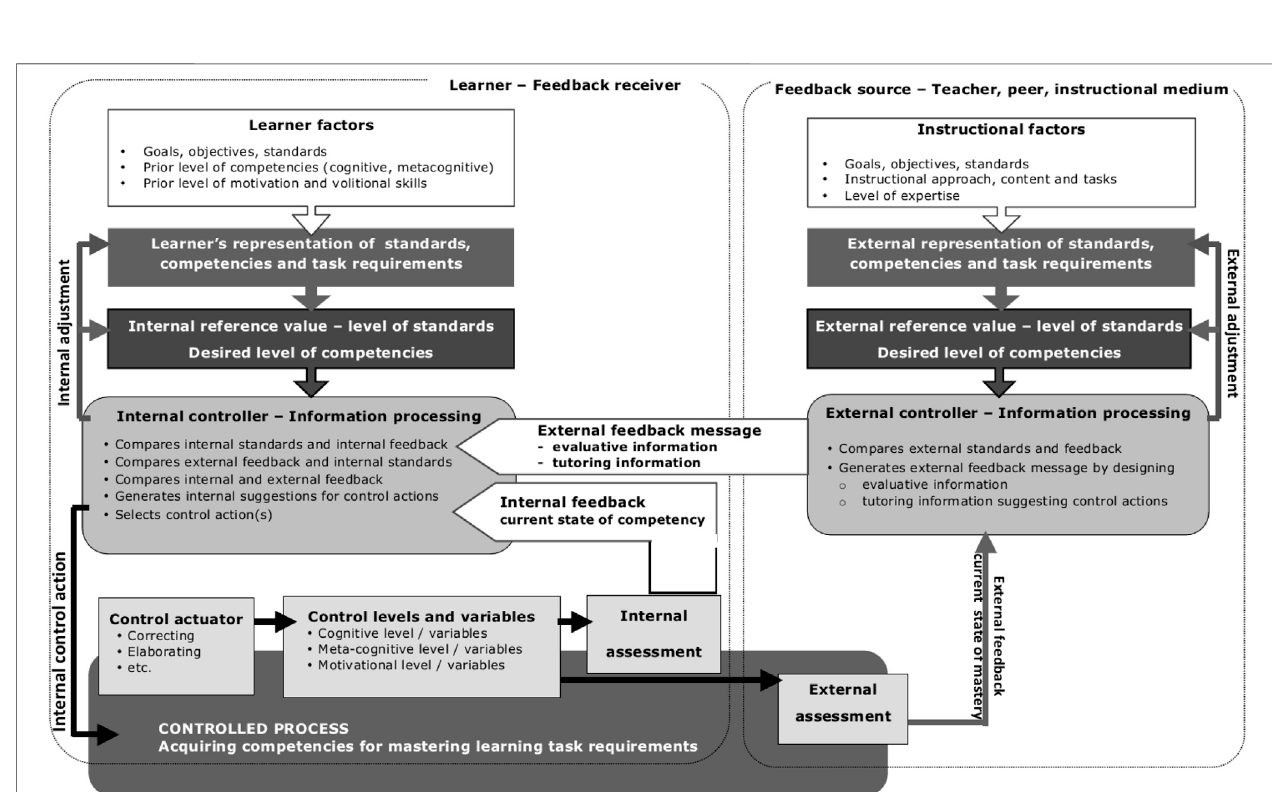
FIGURE 10 | Narciss (2013) feedback model explaining